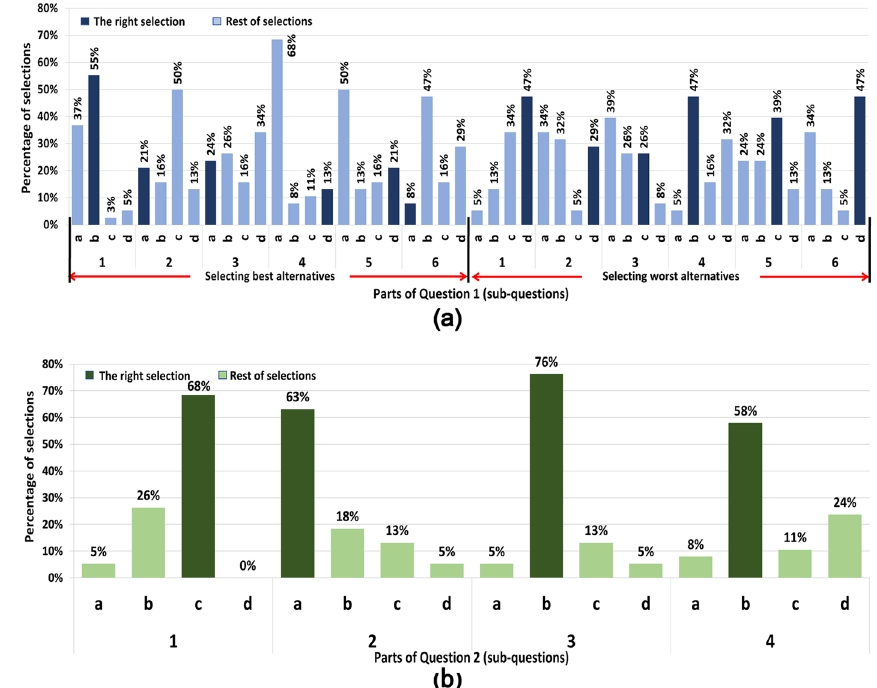
Fig. 6 Survey results: a Question 1. b Question